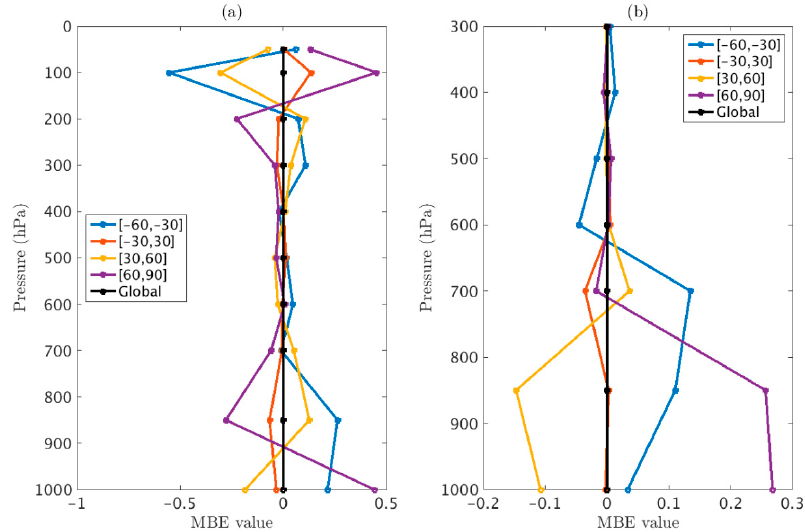
Figure 6. The MBE of HIRS retrievals compared to 2011–2012 radiosonde observations for global and latitude bands (HIRS values minus radiosonde values) for ( a ) temperature (°C) and ( b ) specific humidity (g/kg).